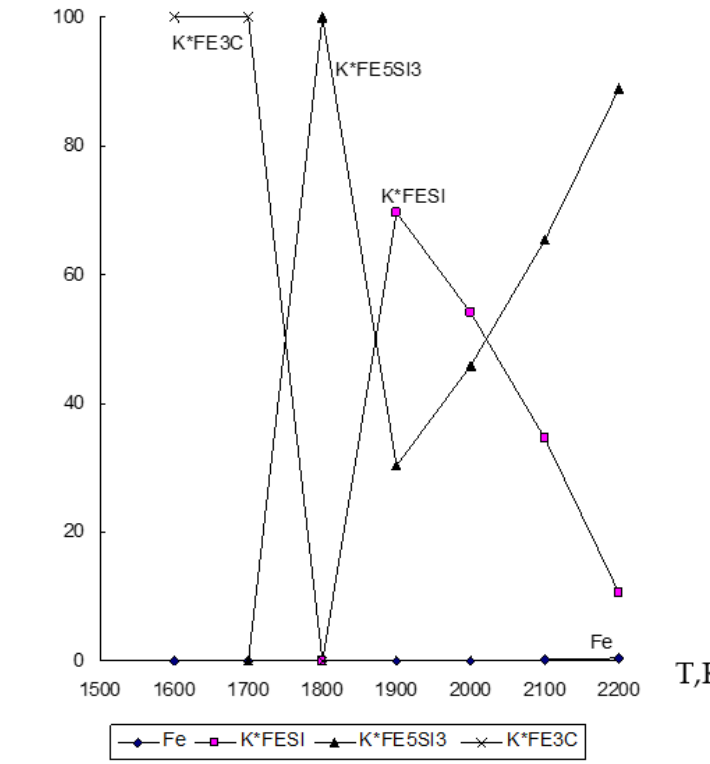
Figure 3. Influence of temperature (T) on the degree of distribution ( α ) of Fe in the ZnO · SiO 2 - FeO · Fe 2 O 3 -C system.